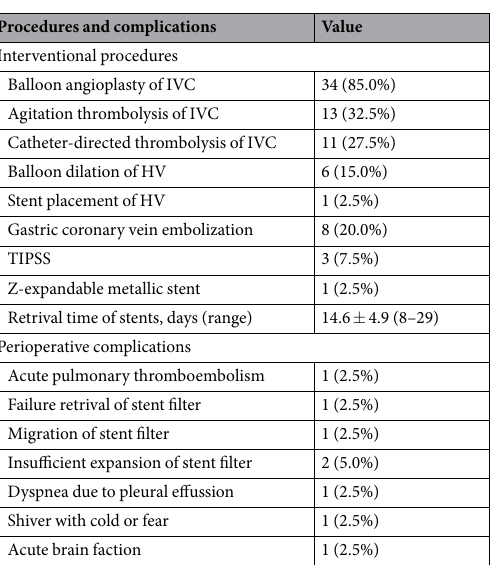
Table 3. Interventional procedures and perioperative complications. IVC, Inferior vena cava; HV, Hepatic vein; TIPSS, Transjugular intrahepatic portosystemic stent